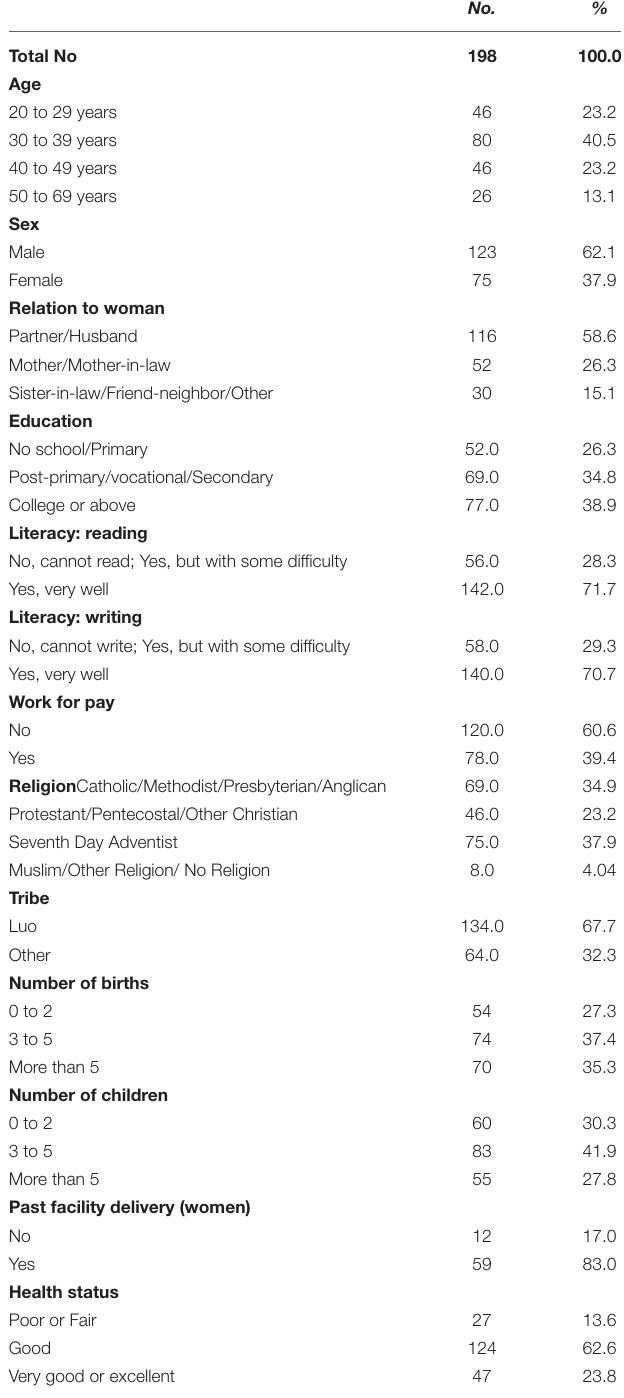
TABLE 1 | Univariate sociodemographic distribution of predictor variables.